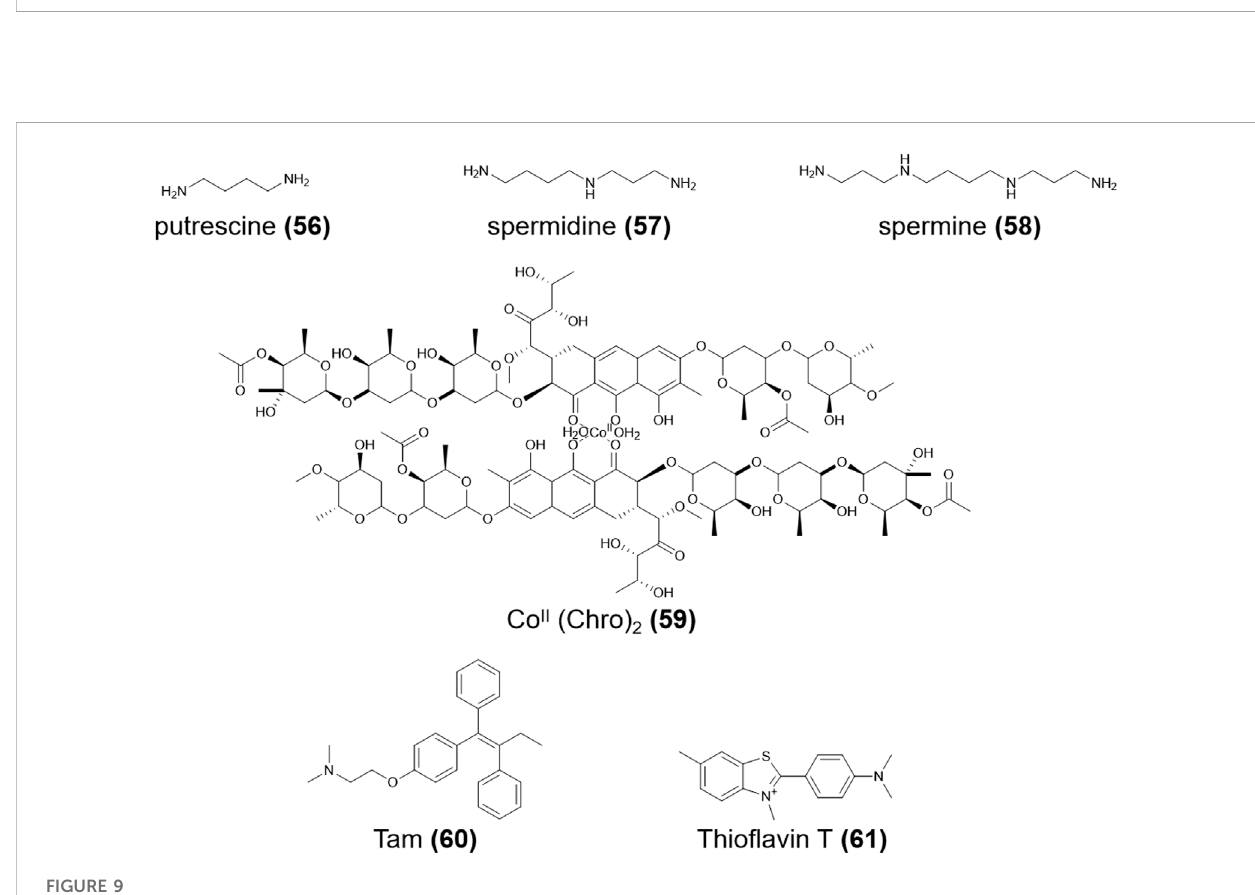
FIGURE 9 Structures of compounds ( 56 – 61